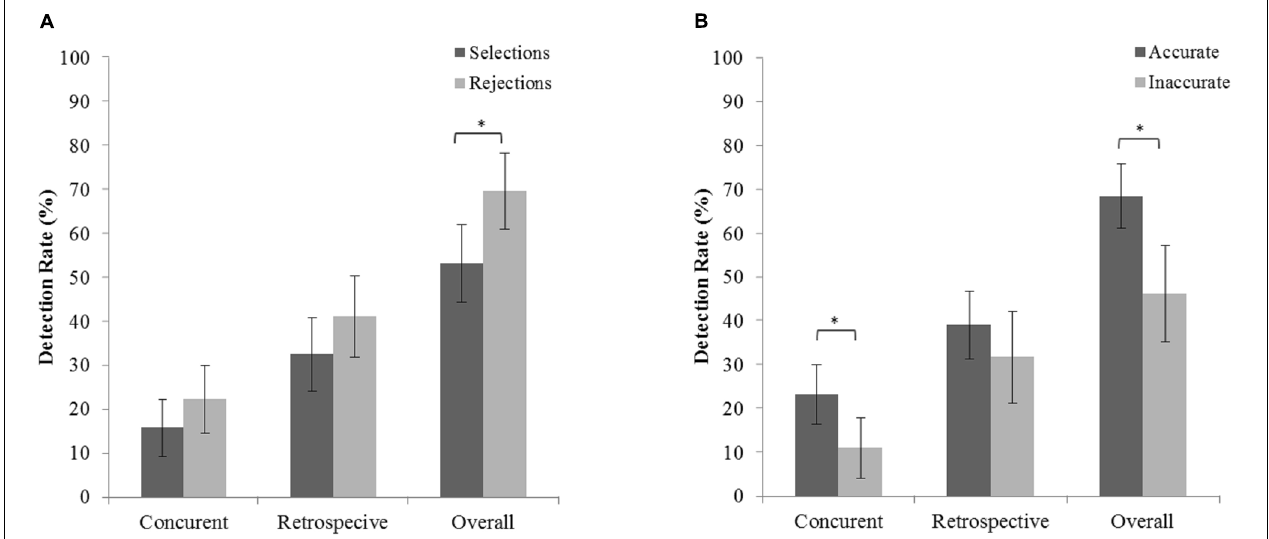
FIGURE 4 | Proportion of concurrent, retrospective, and overall detection rate as a function of lineup selection (A) and identification accuracy (B) . Error bars represent bootstrapped 95% confidence intervals. Asterisk represents a statistically significant difference ( ∗ p < 0.05).